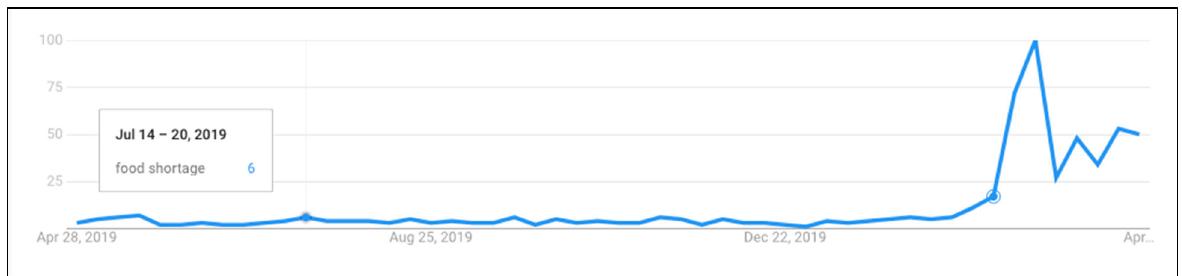
Figure 1b. Search Interest for Food Shortage Coincides with Beginning of Pandemic (12 months)